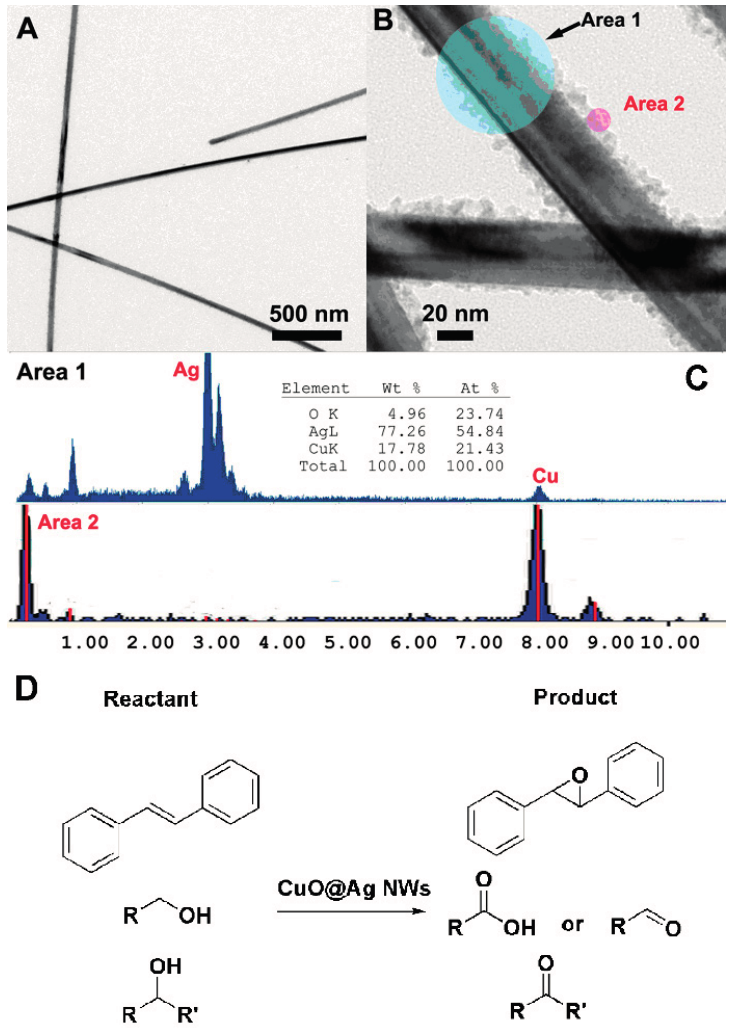
Figure 8. ( A ) The TEM image of Ag NWs; ( B ) The TEM image of CuO@Ag NWs; ( C ) The EDS spectrum of CuO@Ag NWs; ( D ) The epoxidation of trans -stilbene and the oxidation of alcohols using CuO@Ag NWs as catalysts